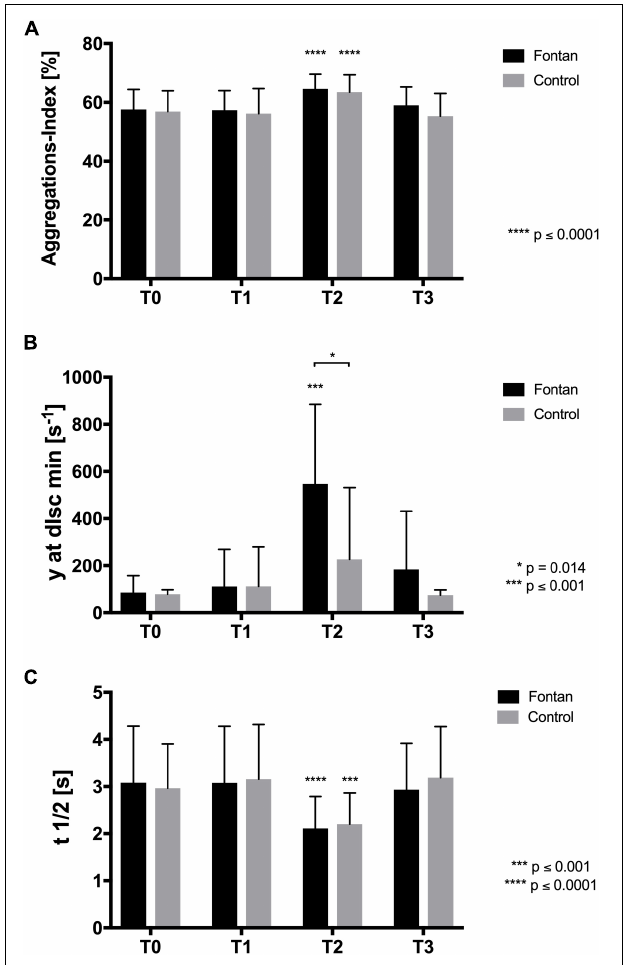
FIGURE 6 | Aggregation and disaggregation balance. (A) Aggregations index (AI) was comparable between Fontan patients and healthy controls. Values significantly increased at T2 in both groups and returned to initial value at T3. (B) y at dIsc min representing the minimum shear stress balancing RBC aggregation-disaggregation was comparable between Fontan patients and healthy controls at T0 and T1, respectively. At T2, y at dIsc min significantly increased in Fontan patients compared to control. (C) Aggregation half-time ( t 1 / 2 ) was comparable between the two tested groups. Values significantly decreased in both groups at